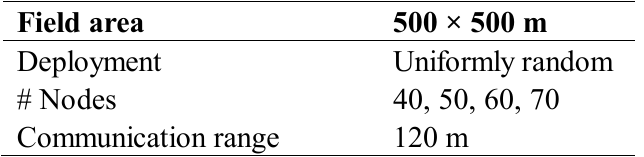
Table 2. Experimental setup for evaluation with number of nodes.